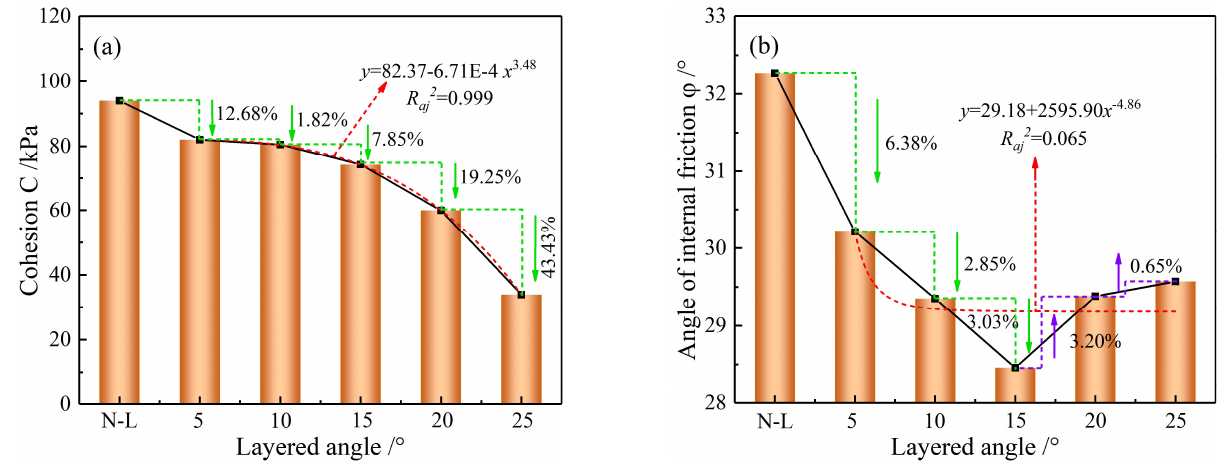
Figure 11. Analysis of cohesion and internal friction angle: ( a ) cohesion; ( b ) internal friction